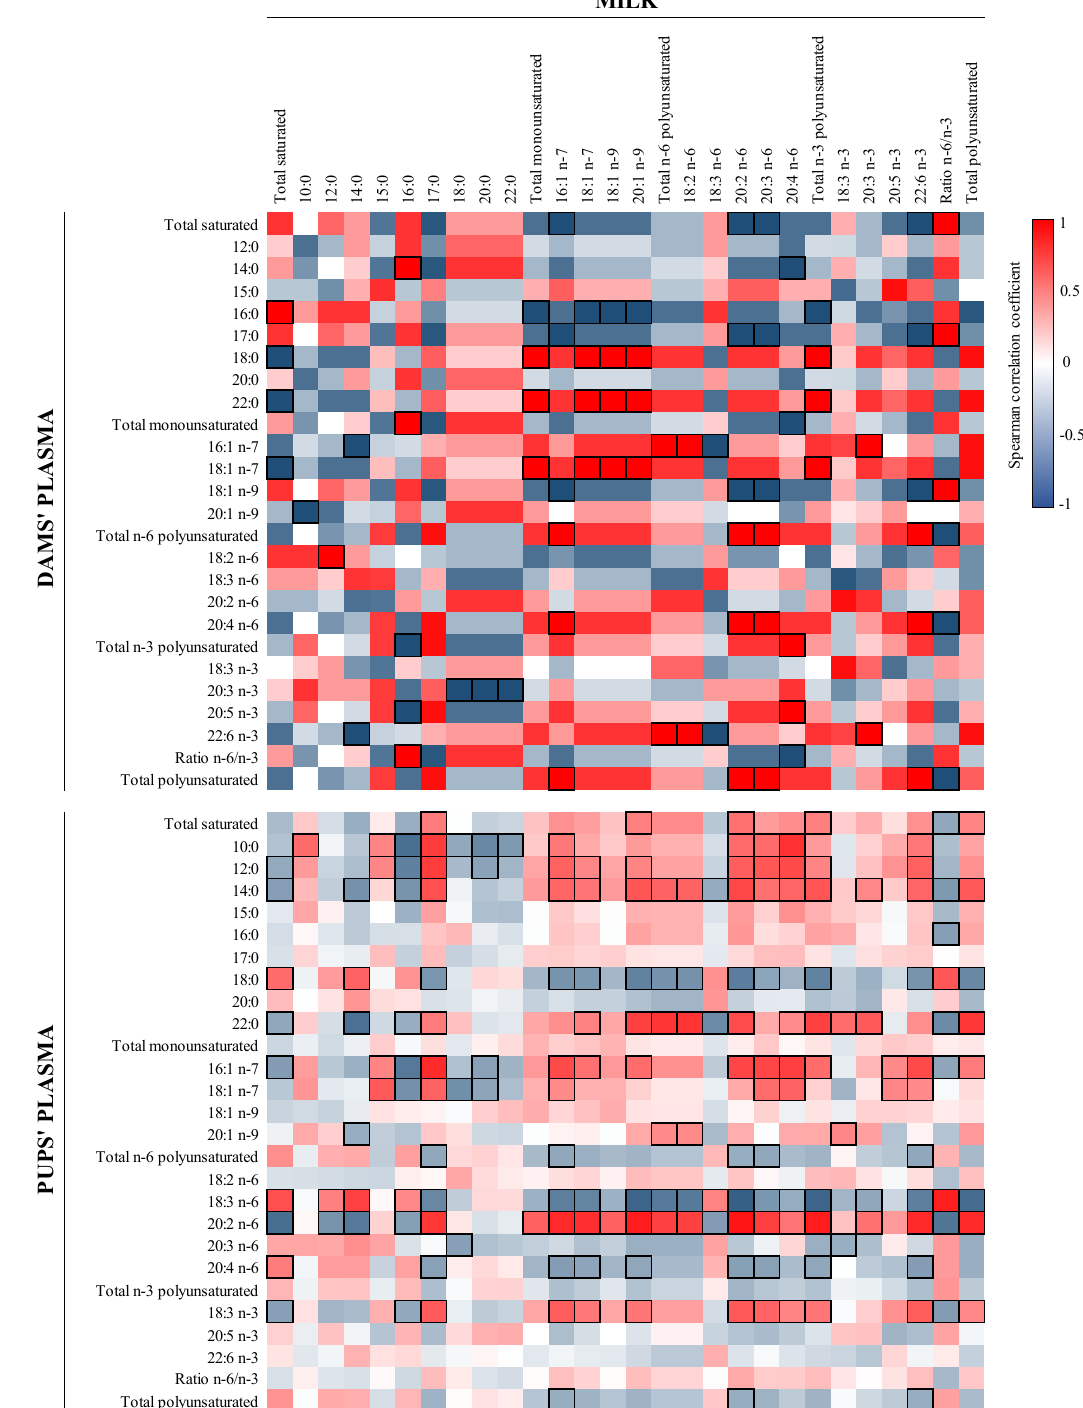
Figure 1. Correlation between the FA composition of milk and that of dams’ and pups’ plasma. The Spearman correlation coefficient is represented in the heat map following the color in the legend. Correlations with statistical significance ( p < 0.05) are shown in a bold frame. Results derived from n = 6 for milk and dams’ plasma and n = 24 for pups’ plasma.